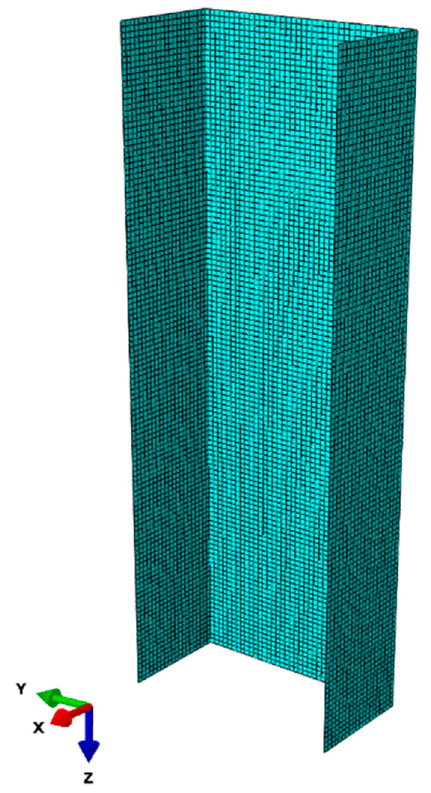
Figure 2. Simulation model of the GFRP strut.